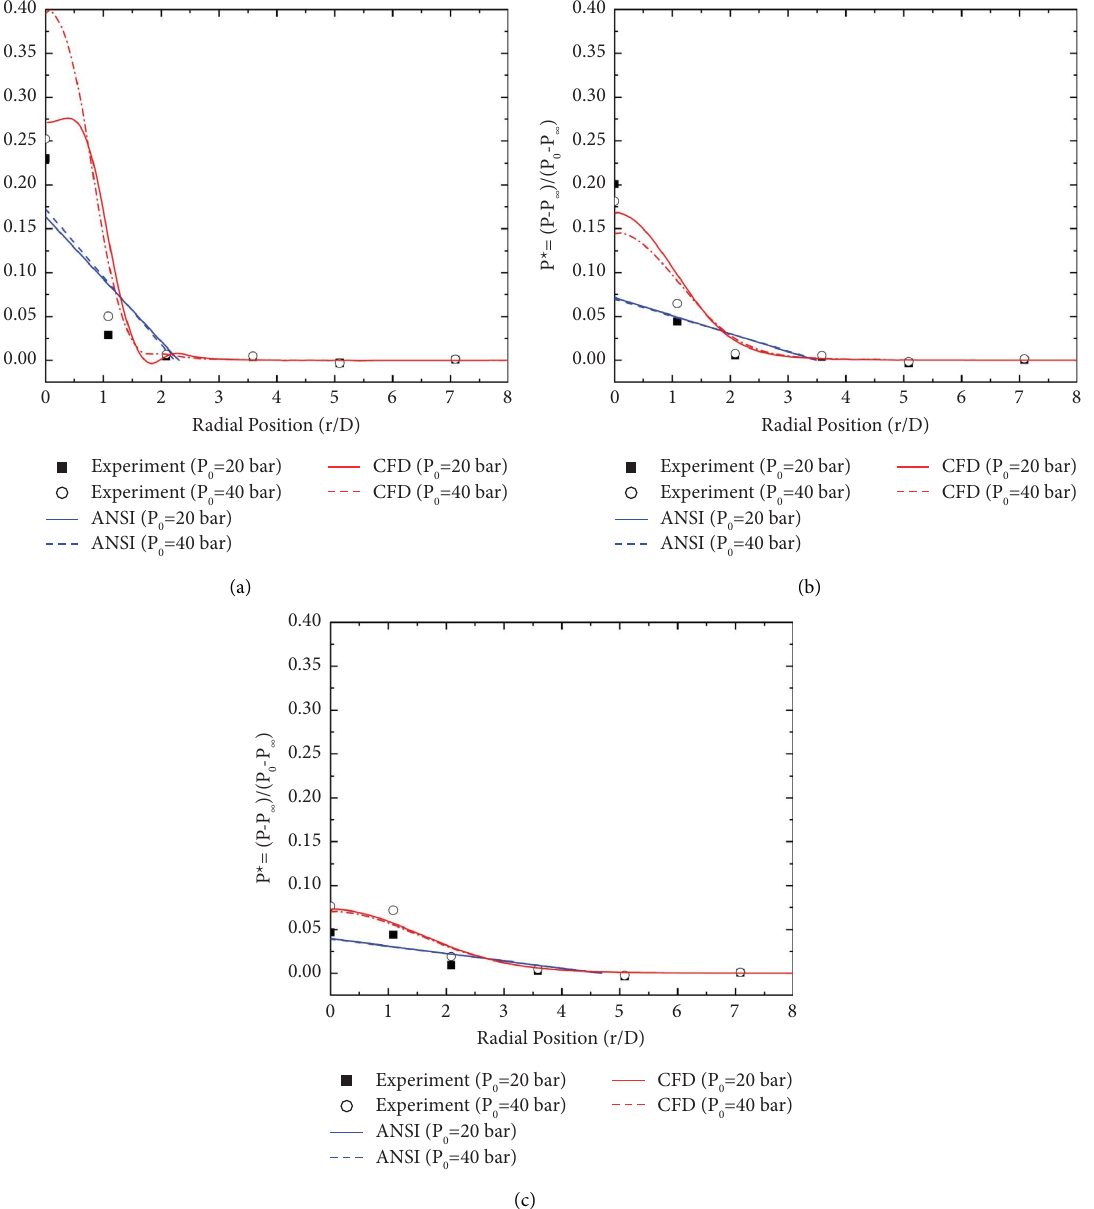
Figure 4: Impinging jet pressure on the target plate: L